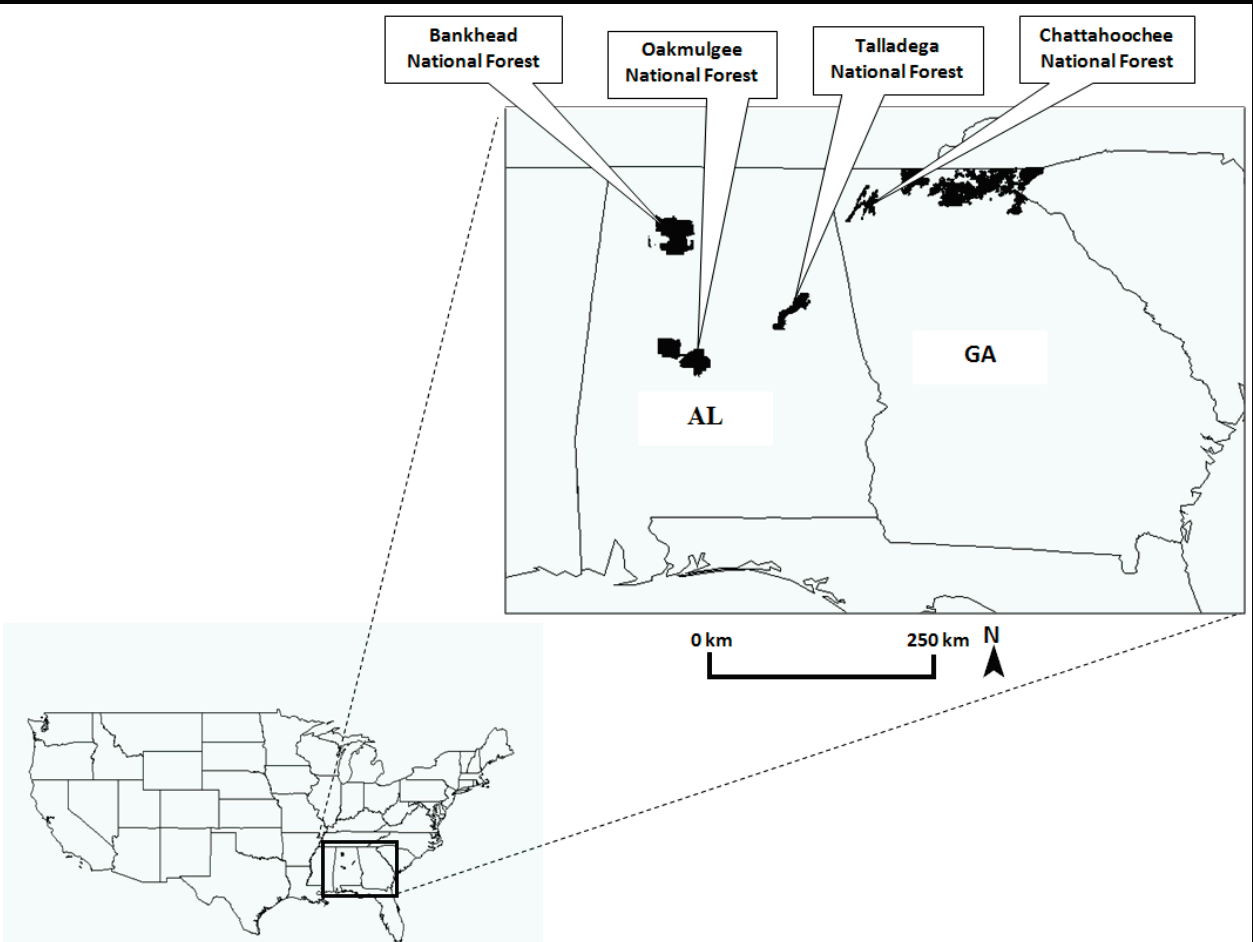
Figure 1. Locations of Bankhead, Oakmulgee, Talladega, and Chattahoochee National